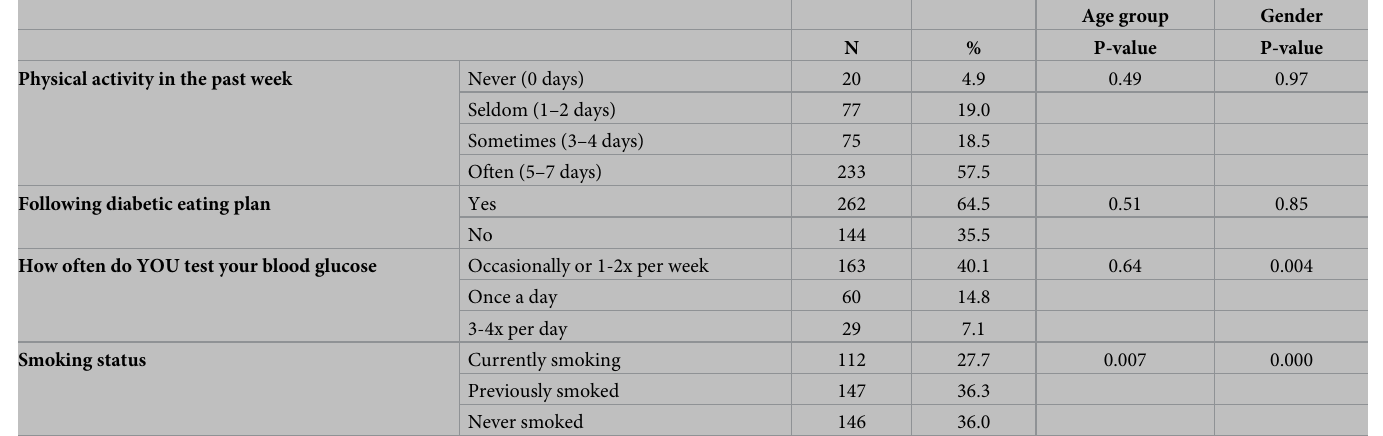
Table 3. Self-management practice of lifestyle risk